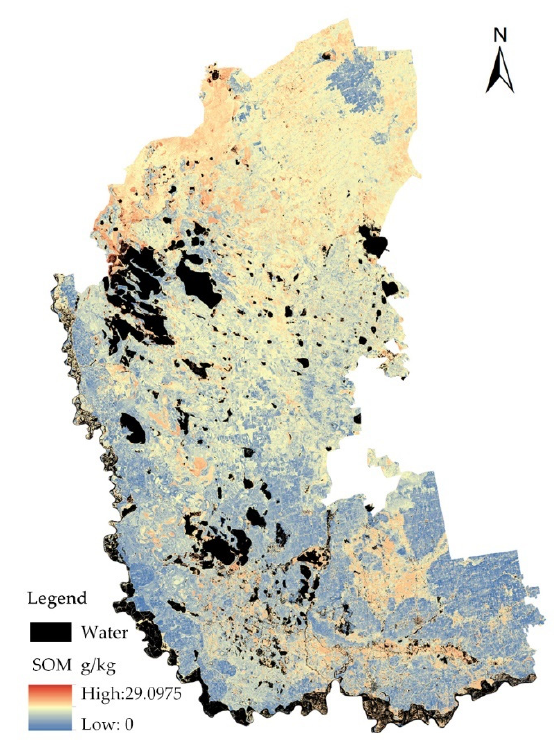
Figure 6. Inversion result of model.